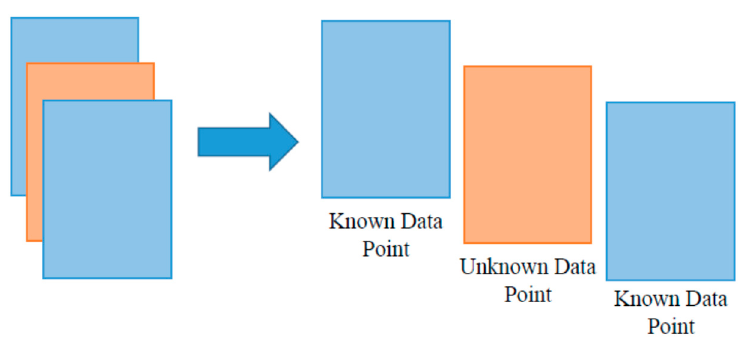
Figure 7. Information sharing at data level.